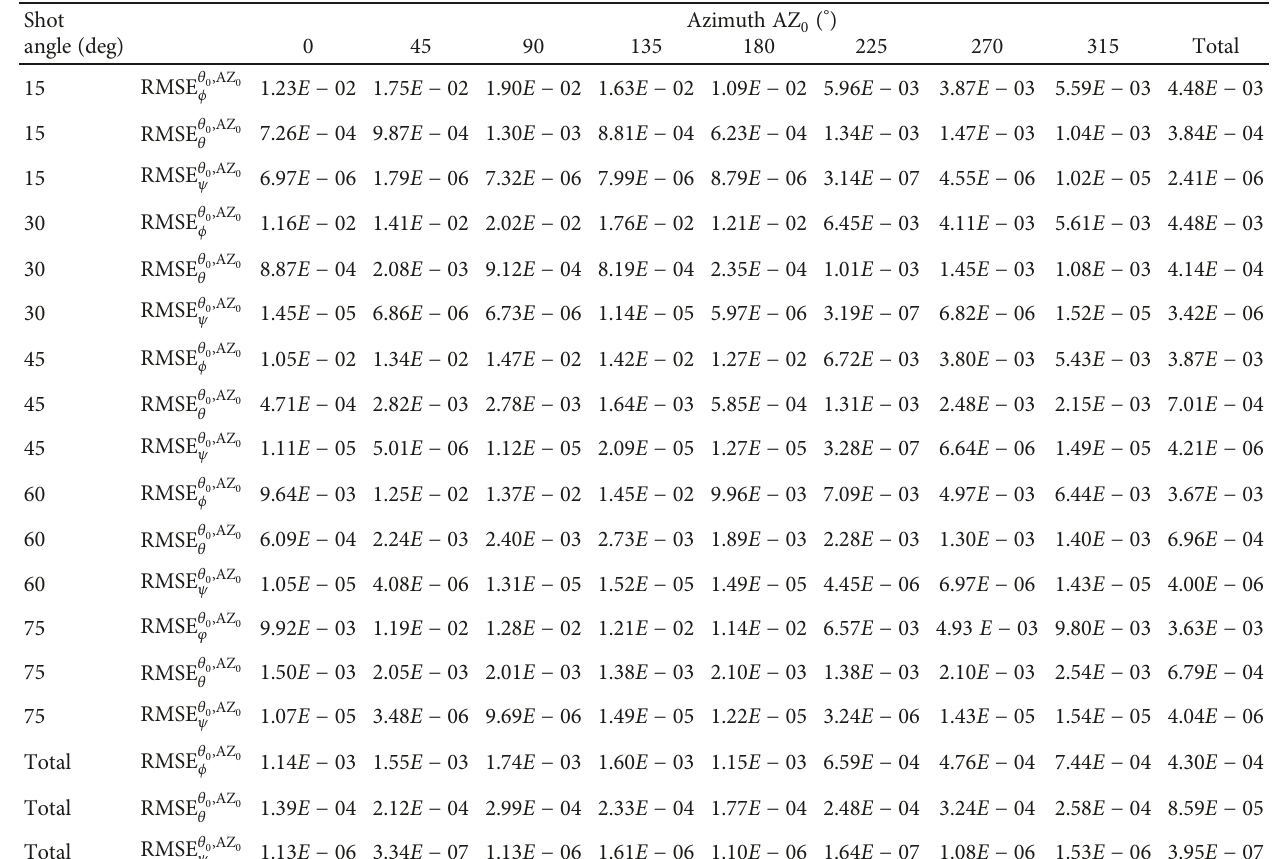
Figure 7: Representation of z angular velocity vector RMSE along the whole trajectory for each shot angle and for the 8 azimuths tested. B Table 2: Root mean squared errors along the whole trajectory for a set of shot angles and for the 8 azimuths tested and calculation of a representative mean